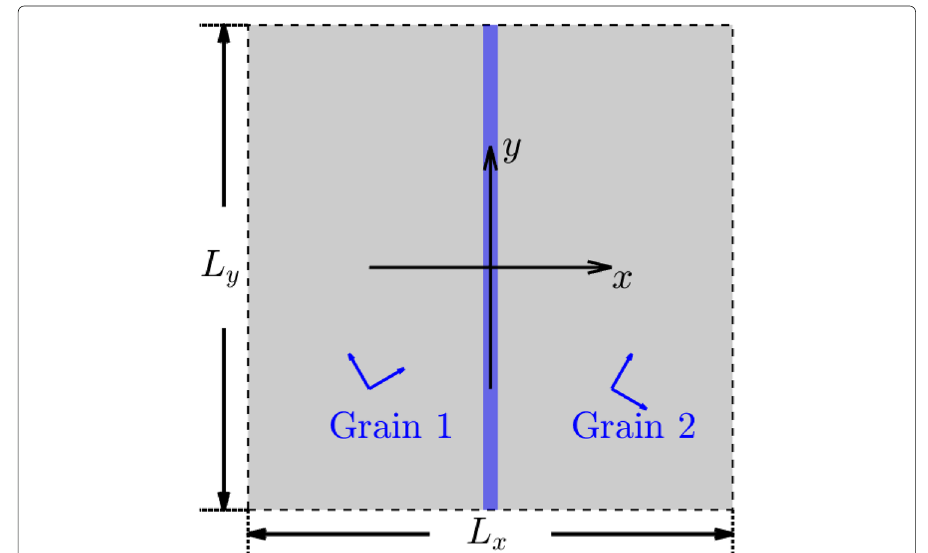
Fig. 6 Schematic of the bicrystal geometry showing a centered (cid:3) 109 ( 13 7 0 )/ 33.4 ◦ grain boundary